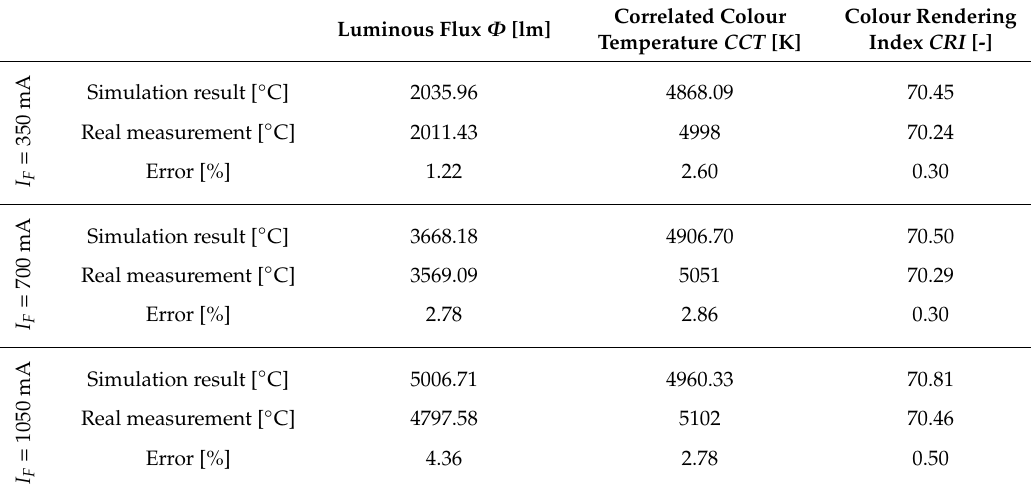
Table 5. The results of simulations and real